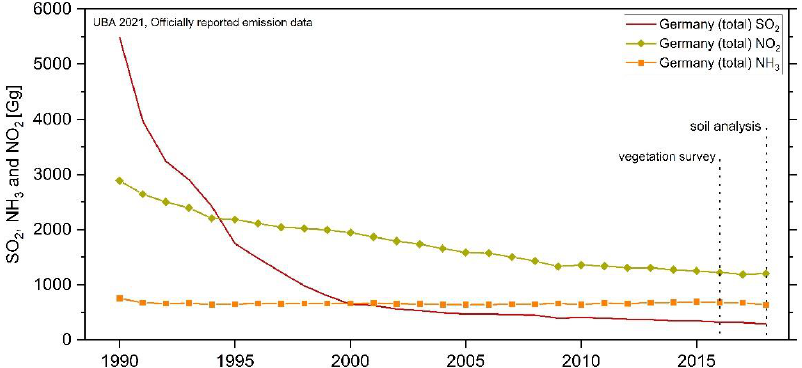
Figure 1. Trends in emissions of main eutrophying/acidifying air pollutants and years of vegetation and soil investigations, presented in this study. Total national emissions of NO x (as NO 2 ), NH x (as NH 3 ), and SO x (as SO 2 ) from 1990 to 2018 at the area of Germany. Datasource: UBA 2021, officially reported emission data. Although S depositions decreased strongly over the last decades, even today their legacies are found accumulated in the mineral soil as SO 4 2− , predominantly specific ad- sorbed to iron (Fe) and aluminum (Al) sesquioxides [19]. The desorption and the release of SO 4 2− into soil solution is held responsible for mineral soil base cation leaching losses with seepage water [10,20 – 22], which might decrease pH at deeper mineral soil layers and delay a recovery from formerly induced soil acidification through air pollutants, espe- cially of acidic soils [23].